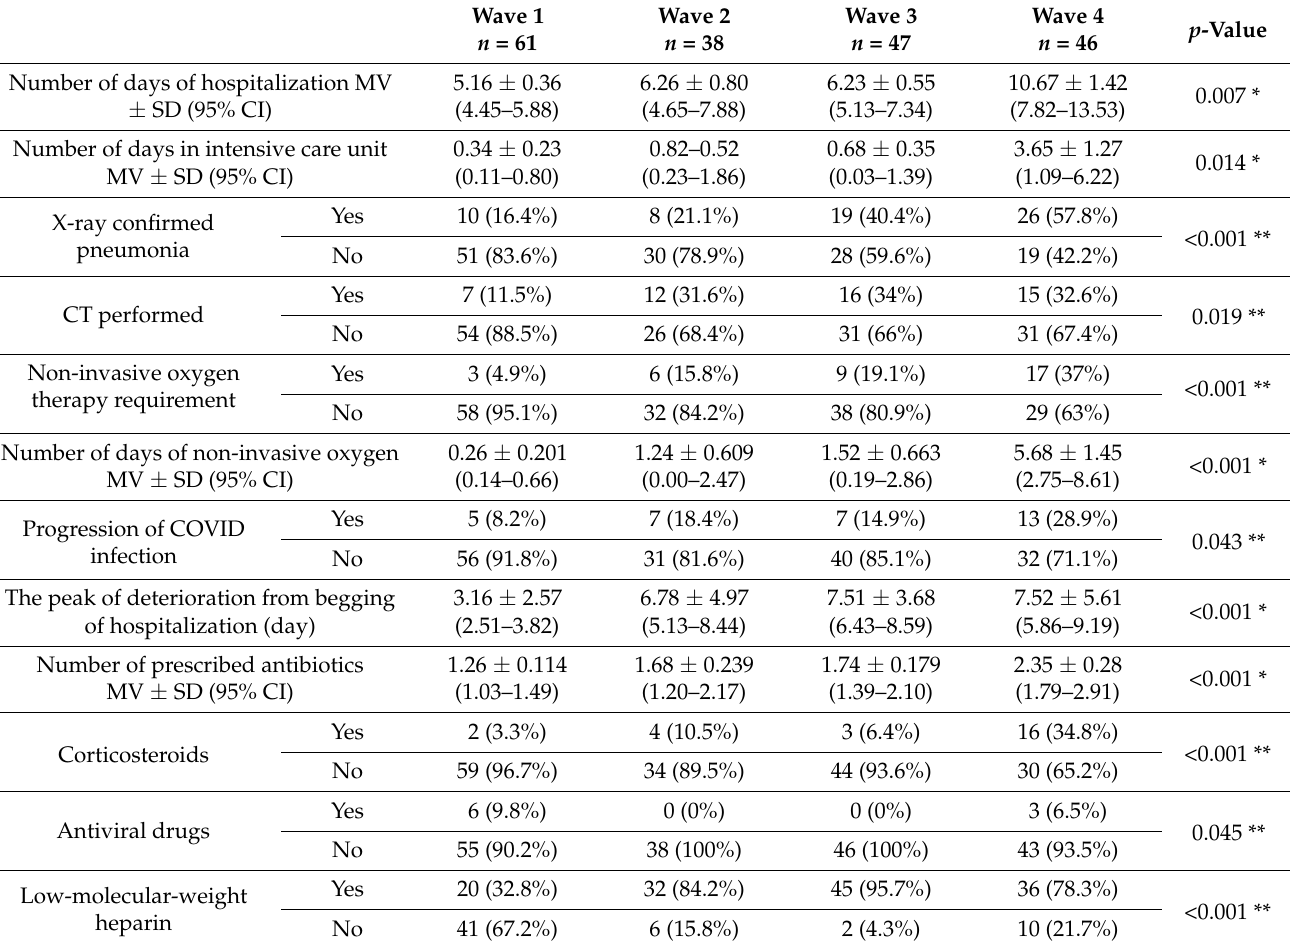
Table 2. Distribution of clinical characteristics in pregnant COVID-19 patients regarding the epidemic